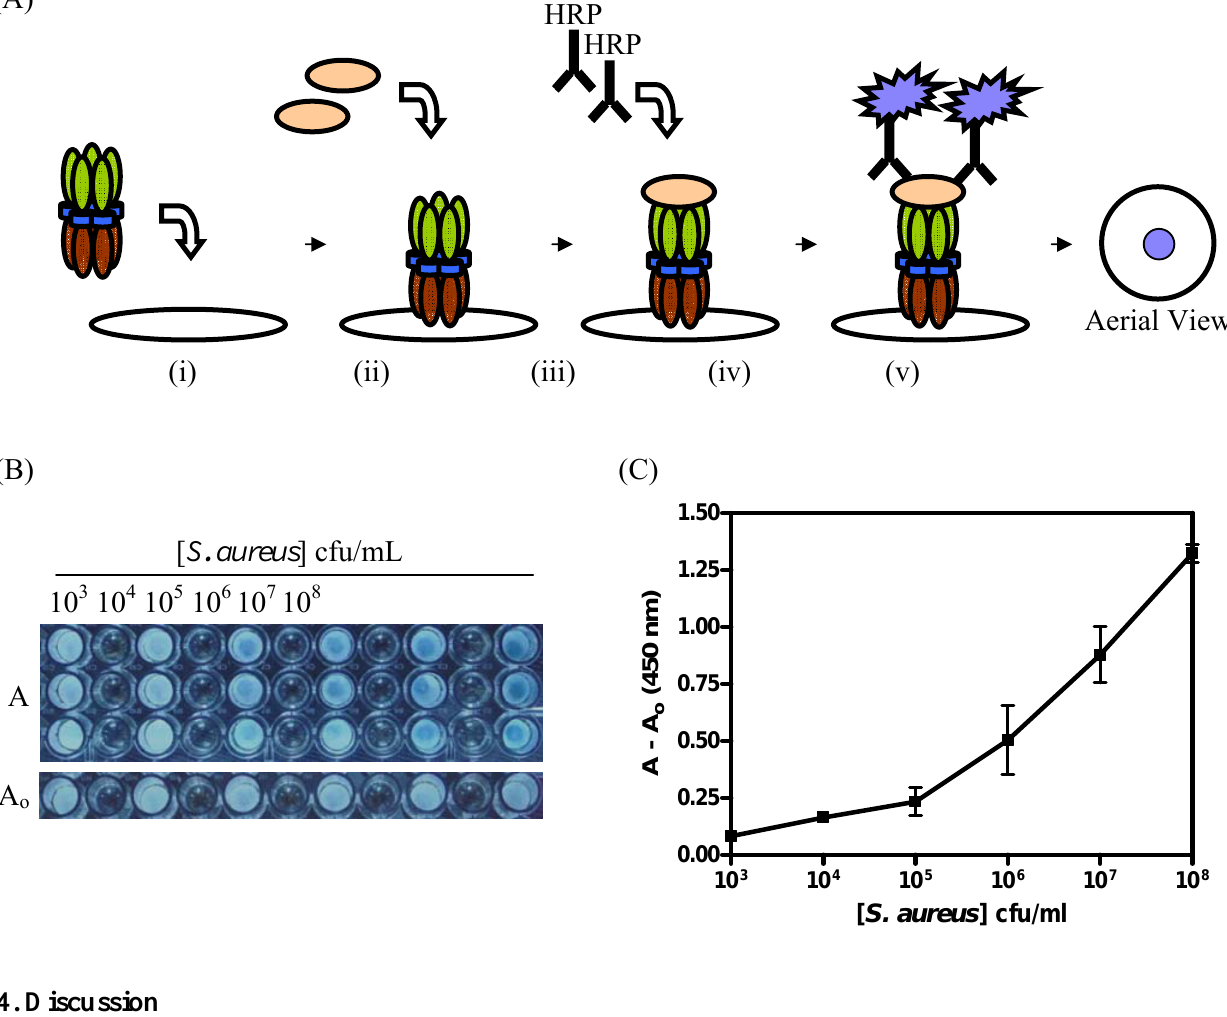
Figure 5. Detection of S. aureus with immobilized CBM9-VTB-HVHP428. (A) Schematic representation of the CBM9-VTB-HVHP428-based biosensor. (i) Loading of bispecific pentamer onto the filter, (ii) S. aureus cells passed over the filter, (iii) HRP labeled anti- protein A IgG passed over the filter, (iv) the filter moved to 96 well plates, substrate applied, and the absorbance read at 450 nm, (v) aerial view of filter after substrate. (B) Photograph of experimental filter discs after removal of HRP substrate from a 96 well plate. (C) Plot of absorbance A (A of CBM9-VTB-HVHP428 impregnated discs) - A (A of control discs 450 o 450 with HVHP428-VTB) versus the number of S. aureus colony forming units (cfu) applied to each disc. Limit of detection = 10 5 cfu/mL (p = 0.05). Error bars represent standard error of the mean (SEM) based on A values from two independent experiments with three 450 replicates in